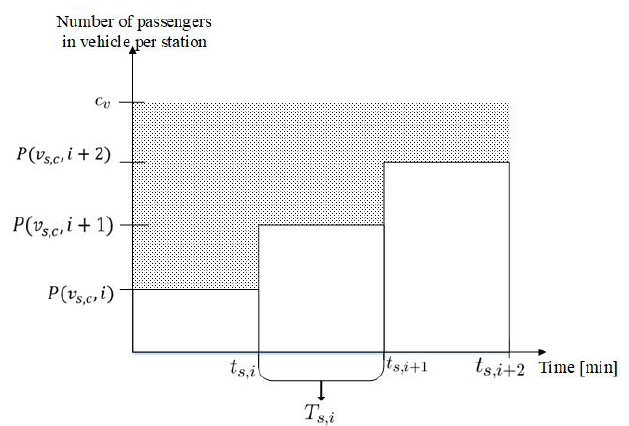
Figure 2. Vehicle occupancy depending on time, between consecutive stations for a given service s